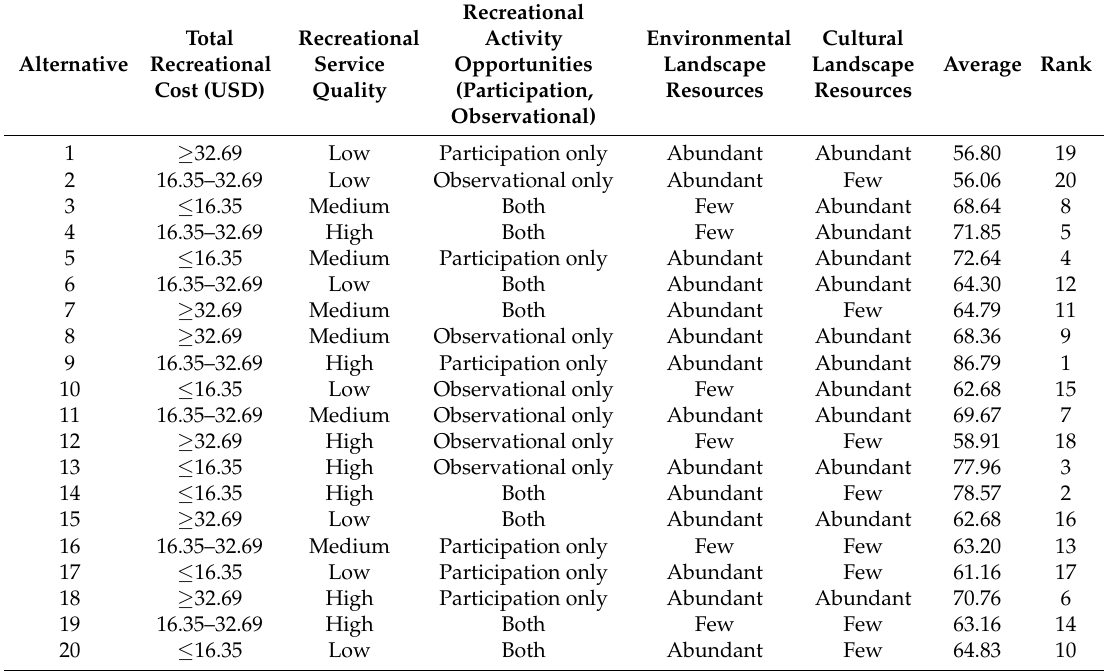
Table 5. An overall statistical analysis of the Calligraphy